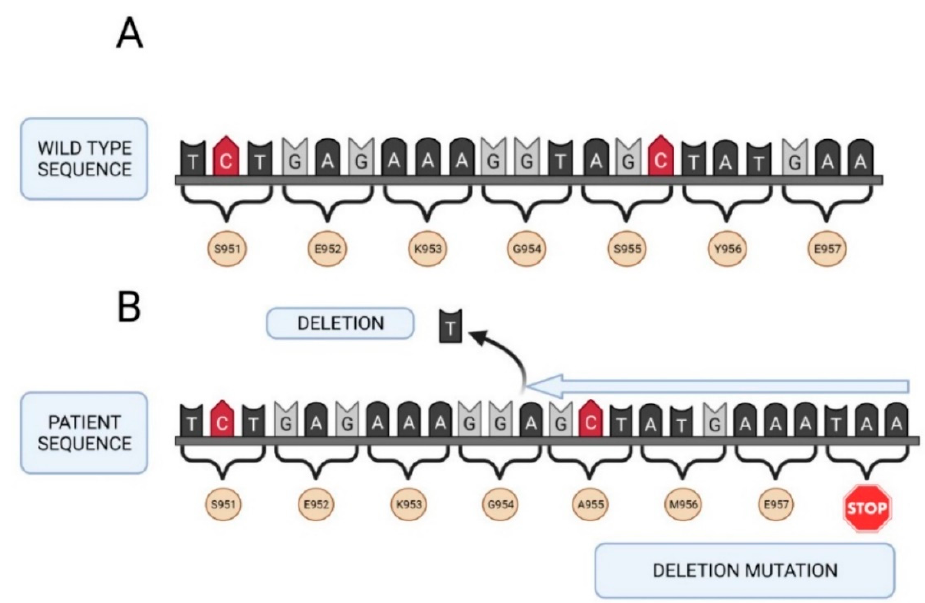
Figure 4. Genetic map of the F5 gene of patient B. ( A ) Native sequence. ( B ) Sequence of the patient with the 2862del, Ser955Alafs*4 mutation (premature stop codon, deletion mutation). Created in Biorender.com (accessed on 6 September 2021). Table 2. Genetic variants identified in the F5 gene in patient A.